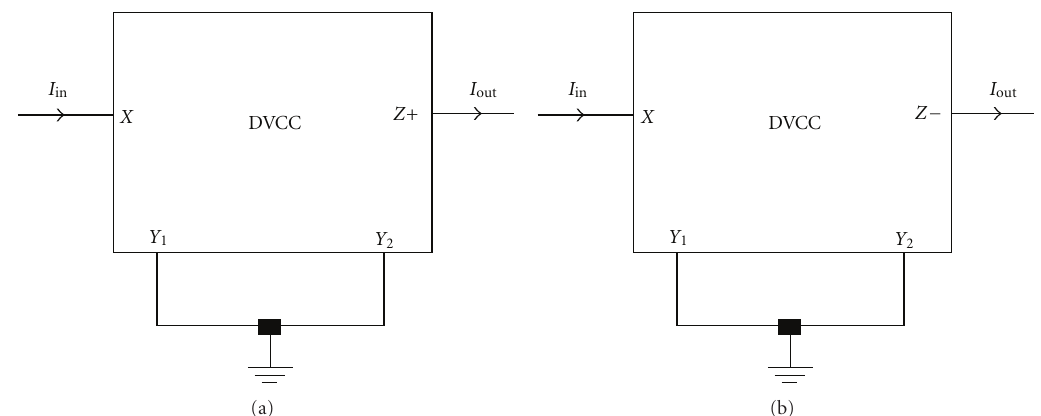
Figure 4: Circuit of current follower using DVCC (a) Inverting (b) Noninverting.